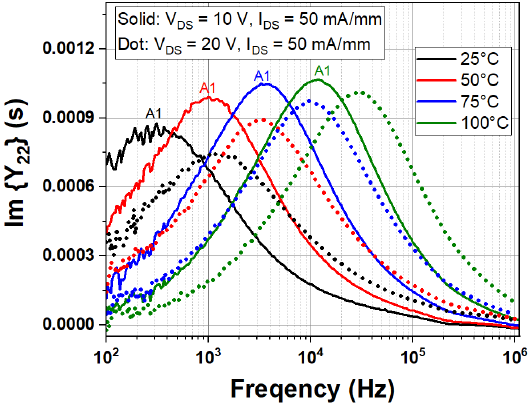
Figure 12. Measured LF Y 22 spectra acquired with two different bias points (a) V DS = 10 V, I DS = 50 mA/mm, and (b) V DS = 20 V, I DS = 50 mA/mm for different chuck temperatures (25 to 100 °C). The LF Y 22 spectra measured at V DS = 10 V are compared with the Y 22 at V DS = 20 V for the same I DS = 50 mA/mm in Figure 12. When the V DS is augmented from 10 to 20 V, the peak position of A1 shifts toward higher frequencies because of the field-enhanced carrier emission caused by the Poole–Frenkel (PF) effect [22,39], which is explained as follows: The augmented electric field in the device lowers the potential barrier for trap-assisted thermal emission; now, the trapped carriers need relatively less thermal activation energy